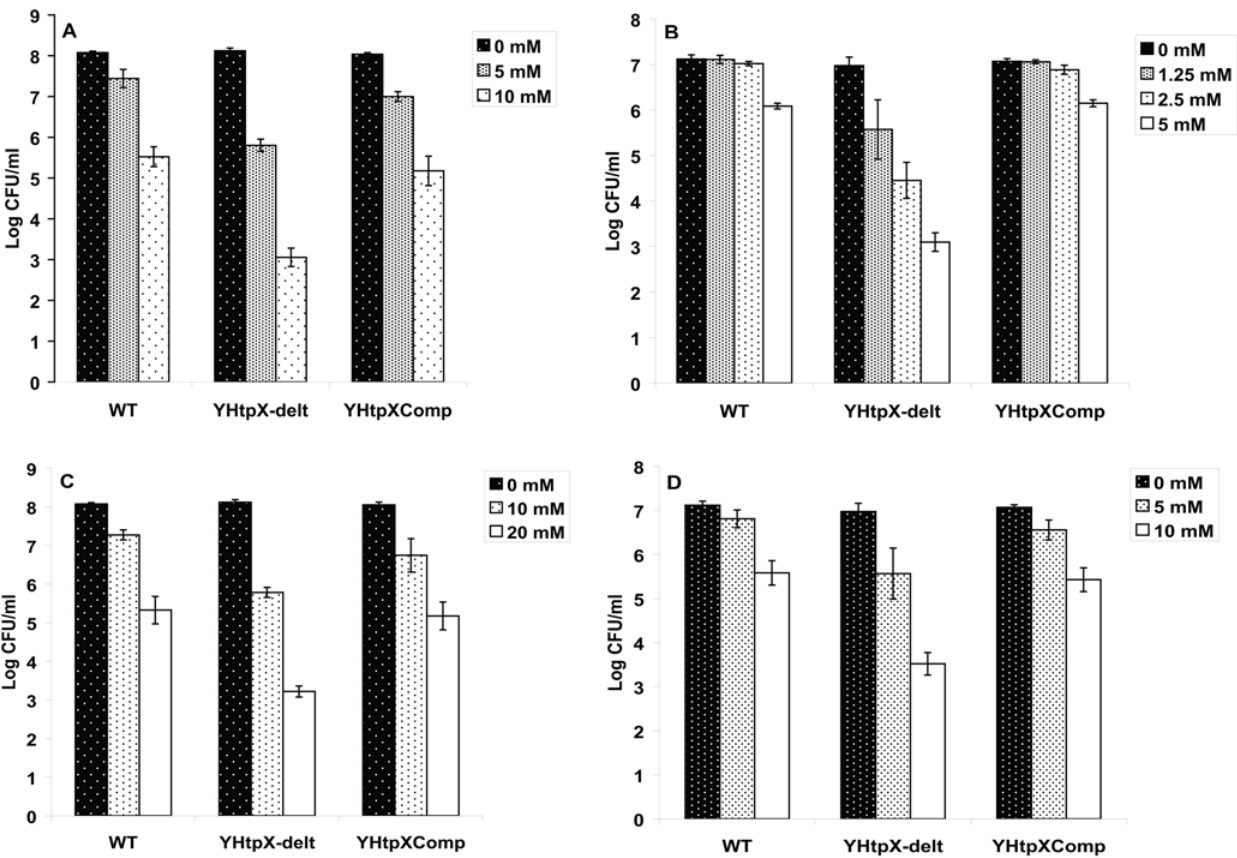
Figure 2. Inactivation of tpx gene renders the mutant more susceptible to oxidative and nitrosative stresses. Survival of YH D tpx compared with WT and the complemented strains in response to H 2 O 2 at 5 and 10 mM (A), DETA/NO at 1.25, 2.5 and 5 mM (B), paraquat at 10 and 20 mM (C) and GSNO at 5 and 10 mM (D). The data shown is a representative of three independent experiments. Data are represented as mean 6 SD of triplicate tests. The CFU counts in the D tpx are significantly lower using a t-test than in WT after exposure to both H 2 O 2 and NO for 24 hours (p , 0.0001 all concentrations for both stress conditions).